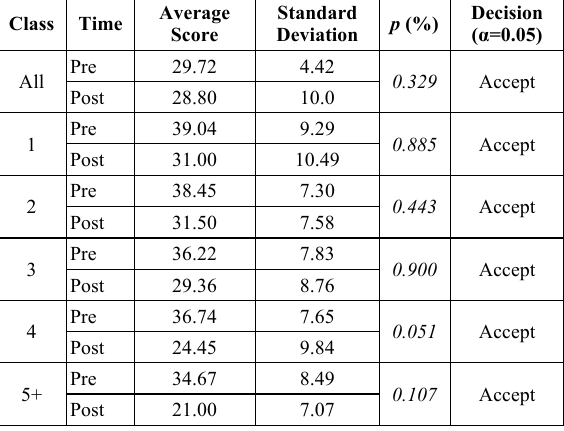
Table 5. Results of Intrinsic Motivation versus Class Standing